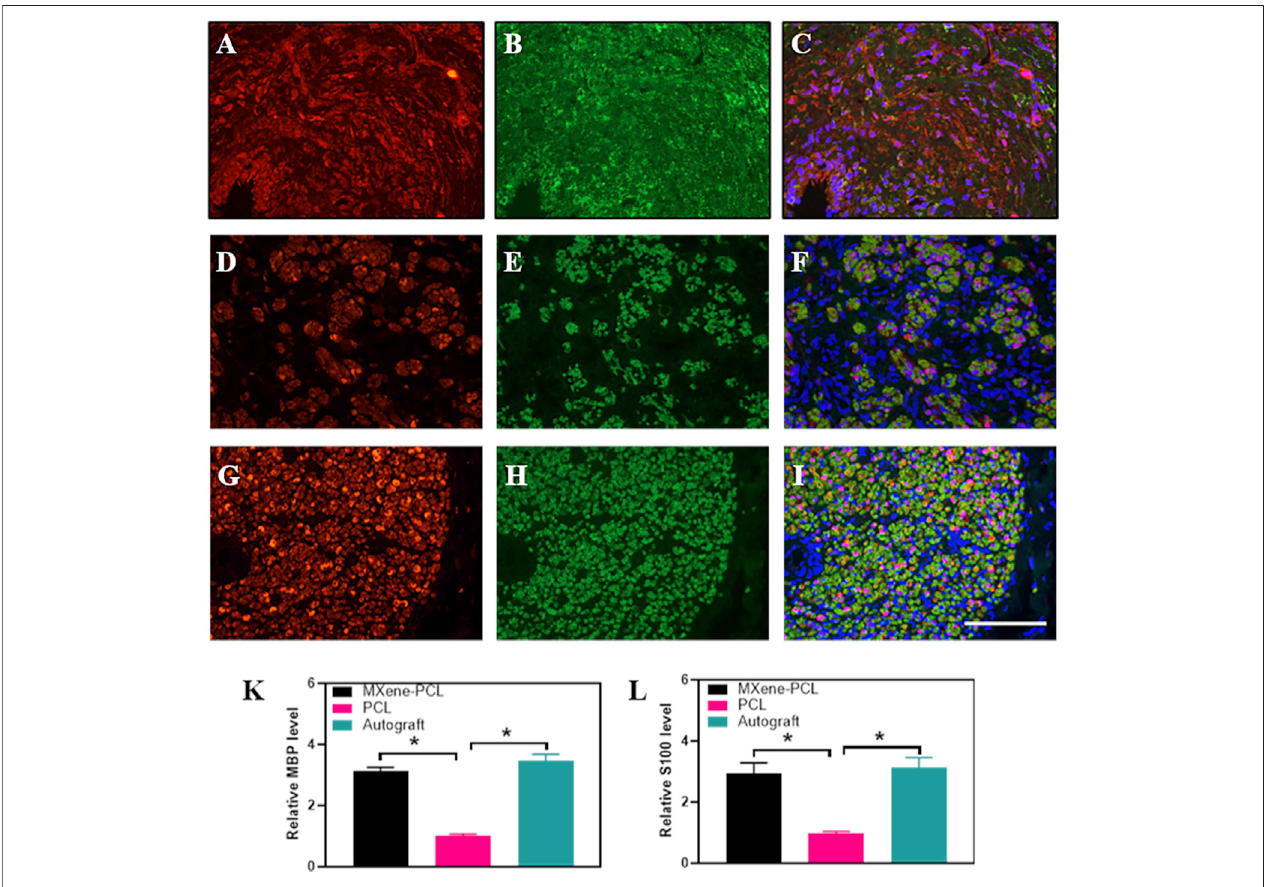
FIGURE8| Immuno fl uorescencestainingofS100(red) andMBP(green)fromMXene-PCL group (A – C) ,PCLgroup (D – F) ,andautograftgroup (G – I) at12 weeks postoperatively. The Relative expression level of MBP (K) and S100 (L) . Experiments were repeated three times. * p < .05. The scale bar is 200 μ m.